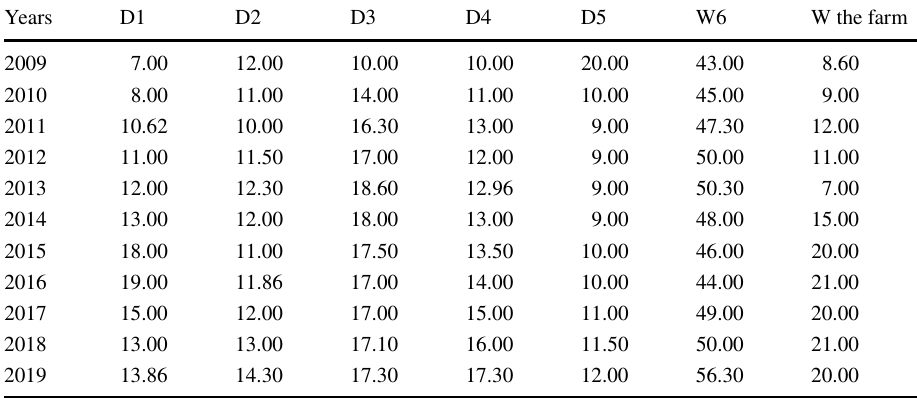
Table 9 Sodium (mg/l) values of water points in the Mougheul area (2009–2019)